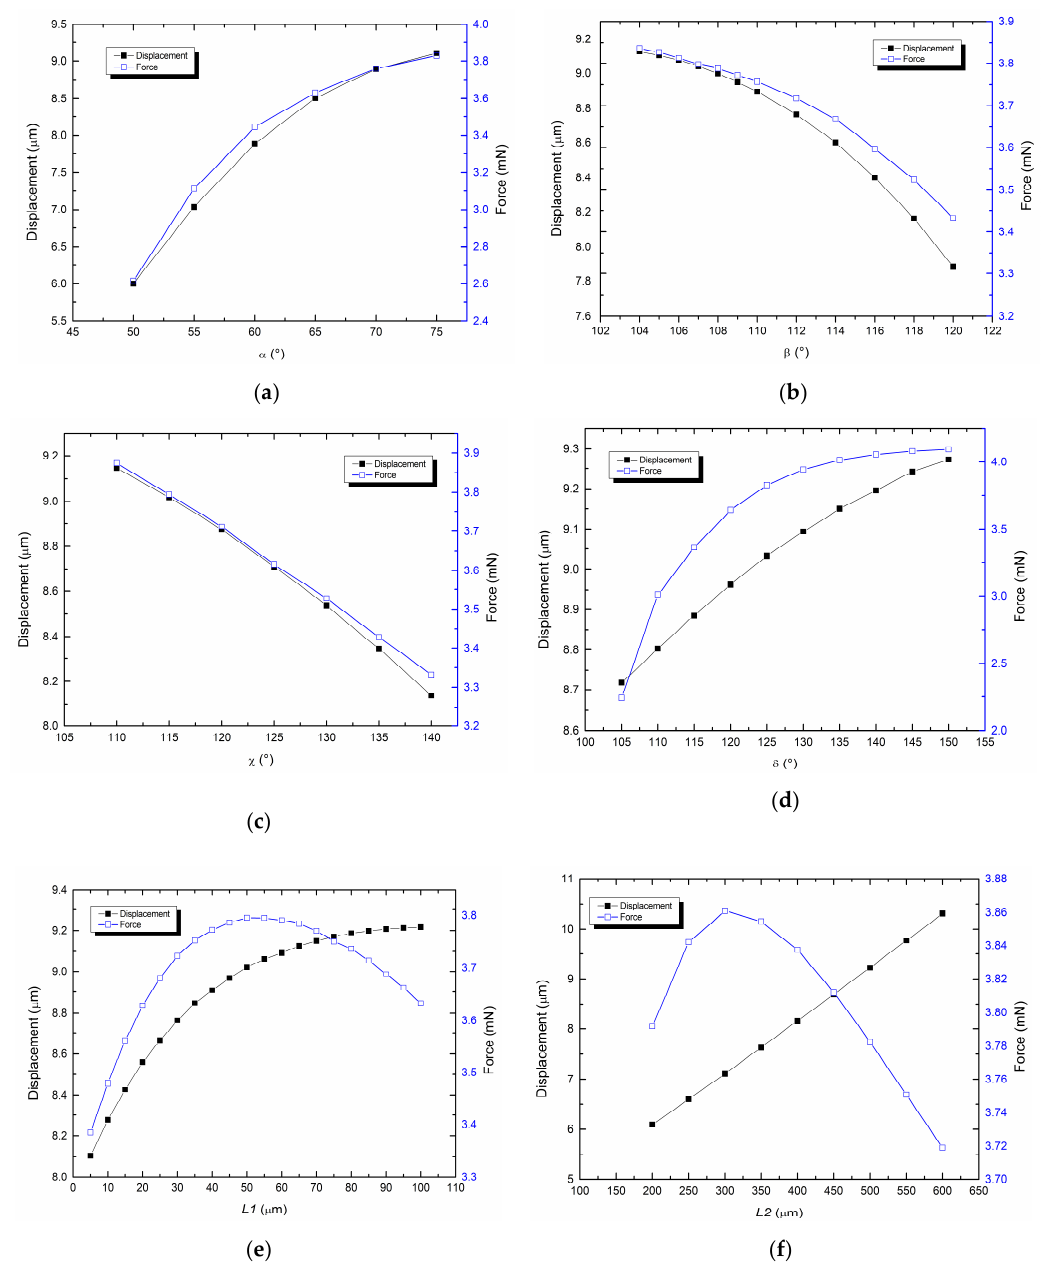
Figure 11. Microgripper. ( a ) α angle, ( b ) β angle, ( c ) χ angle, and ( d ) δ angle vs. displacement and force, respectively. ( e ) L1 and ( f ) L2 vs. displacement and force, respectively.